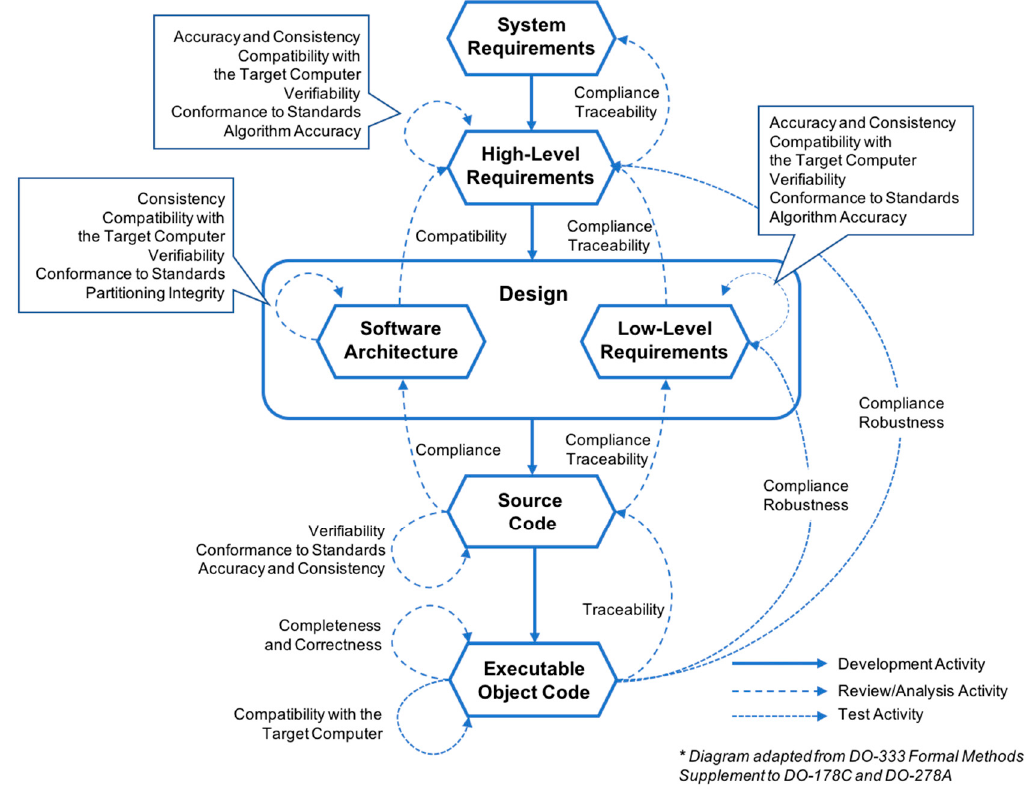
Figure 1. Level A software verification processes.